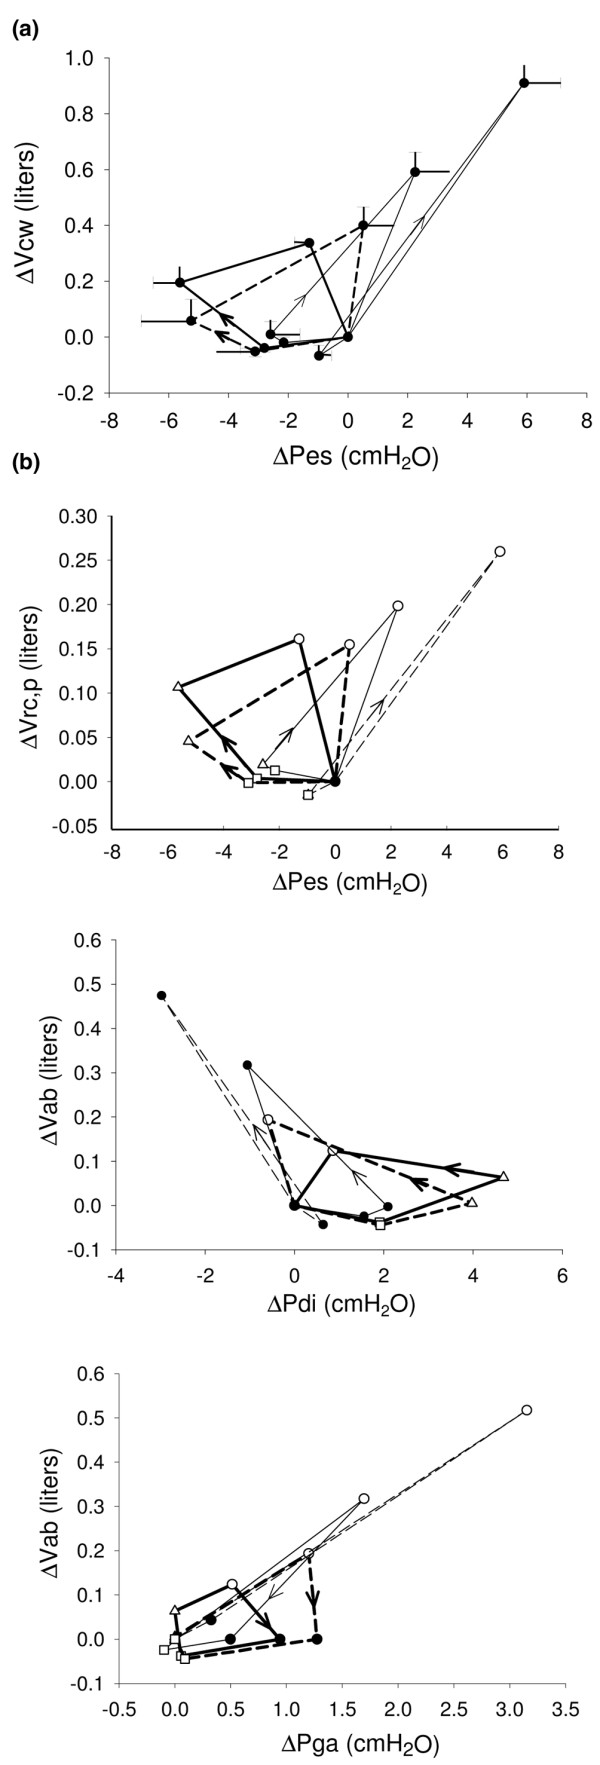
Pressure-volume dynamic relationship of the total and compartment chest wall. (a) Change in oesophageal pressure (ΔPes) versus chest wall volume changes (ΔVcw).  (b) Upper panel: changes in oesophageal pressure (ΔPes) versus pulmonary rib cage volume changes (ΔVrc, p); averaged loops. Middle panel: changes in transdiaphragmatic pressure (ΔPdi) versus abdominal volume changes (ΔVab); averaged loops. Lower panel: changes in gastric pressure (ΔPga) versus abdominal volume changes (ΔVab); Each point represents the mean ± standard error of the mean (i.e. the average of all patients at the different times [see definition in Figure 1]): The loops refer to the different levels of pressure support: 5 cmH2O (solid thick line), 10 cmH2O (dased thick line), 15 cmH2O (solid thin line) and 25 cmH2O (dashed thin line). The arrows indicate the direction of the loops. The symbols in (b) are  t0 (closed circles), t1 (open squares), t2 (open triangles) and t3 (open circles).